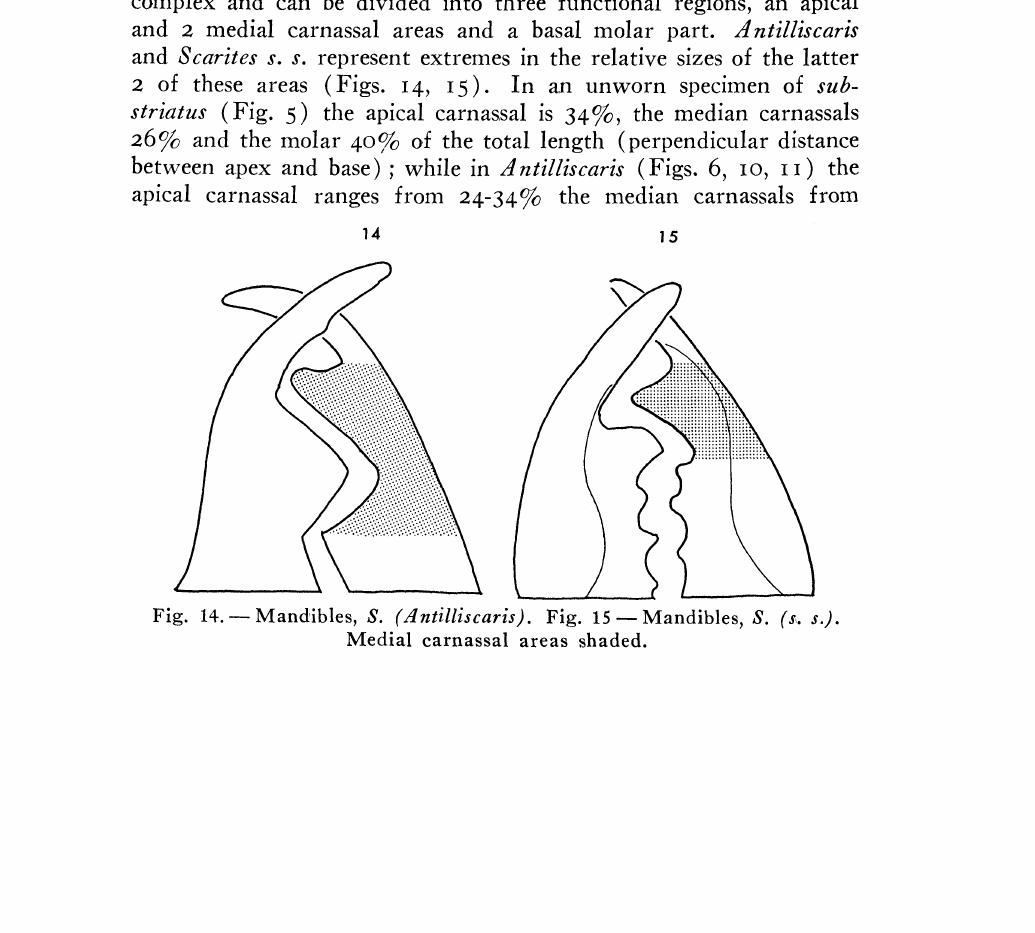
Fig. 14.-- Mandibles, S. (/lntilliscaris). Fig. 15 Mandibles, S. (s. s.). Medial earnassal areas